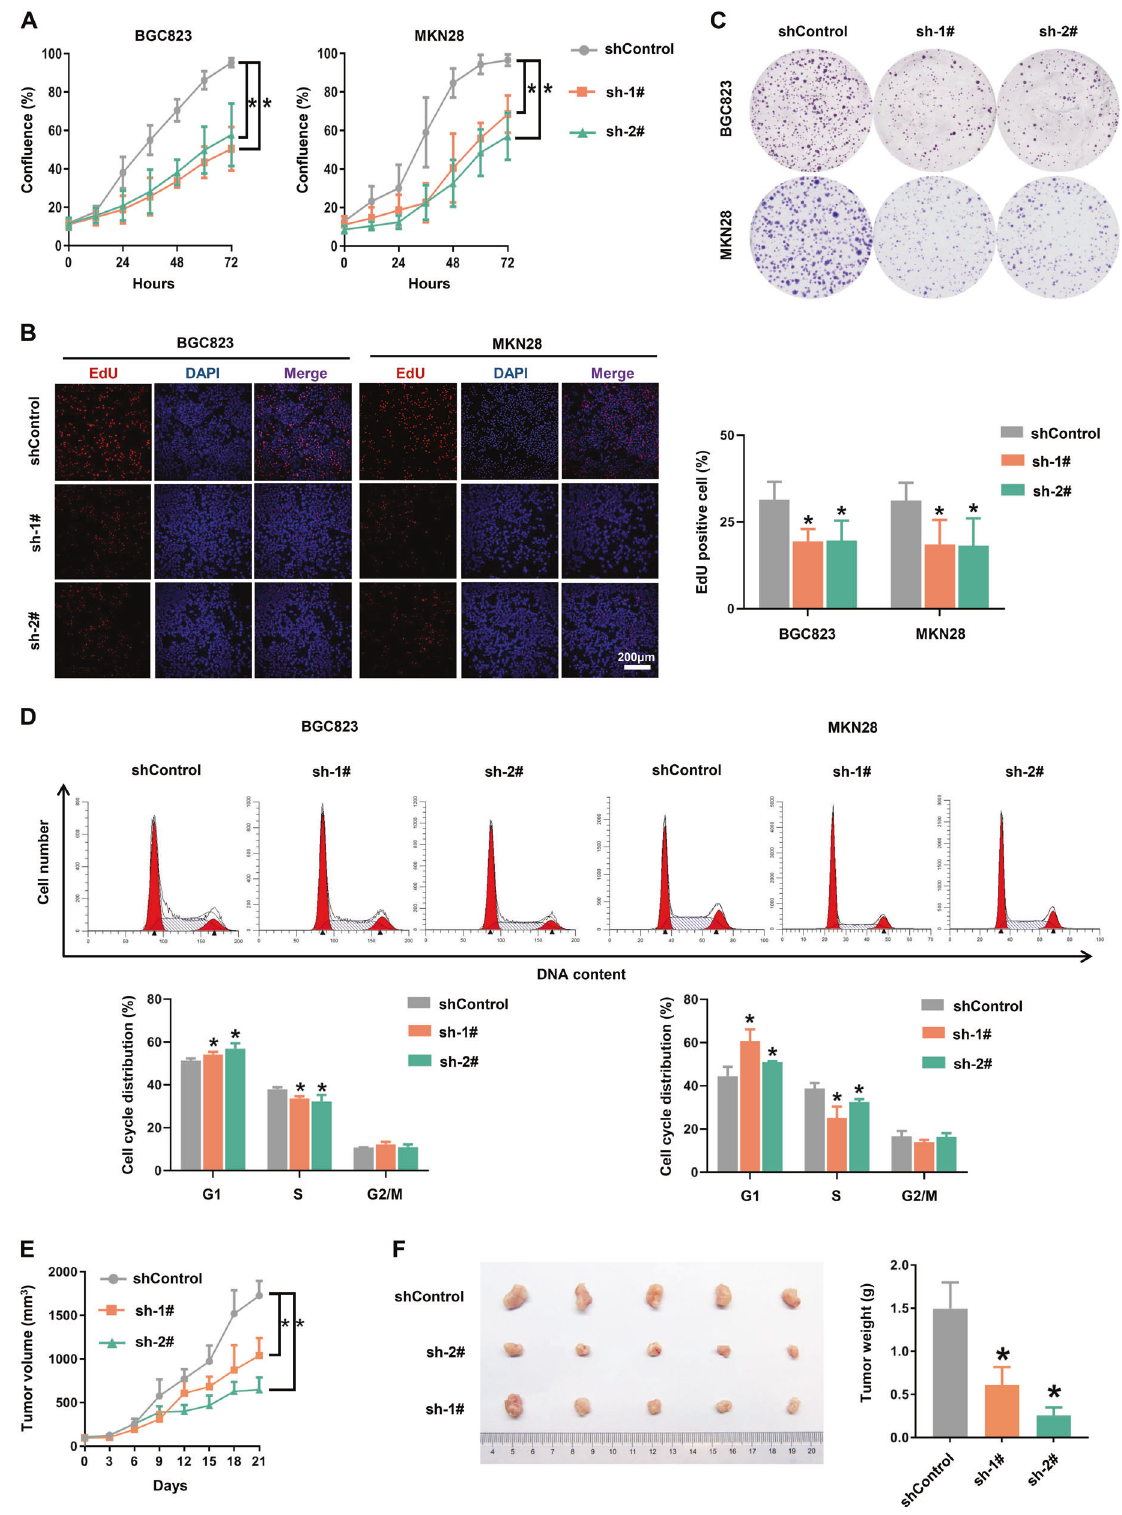
Fig. 3 Knockdown of LINC00205 inhibited cell proliferation and tumor growth. A Cell proliferation was measured by IncuCyte live cell analysis system. B The activity of DNA replication was detected by EdU staining. The representative images were shown (left) and the quantitative measurements of the percentage of EdU positive cells were presented in column shows (right). n = 6 independent experiments, * P < 0.05 vs shControl. Scale bar, 200 μ m. C Colony formation assay. D Cell cycle analysis of the indicated groups. Figure shown was a representative experiments (up). The percentage of cells in each phase was calculated (down). The BGC823 cells with stable knockdown of LINC00205 were xenograft subcutaneously into the immune-de fi cient nude mice ( n = 5 for each group). The tumor volumes were calculated and recorded when the xenograft models established. E The tumor growth curves. * P < 0.05 vs shControl. At the end of experiment, the mice were sacri fi ced and the tumors were collected. F The representative images of xenograft tumors (left). Tumor weight was statistically plotted (right). Cell Death Discovery (2022)